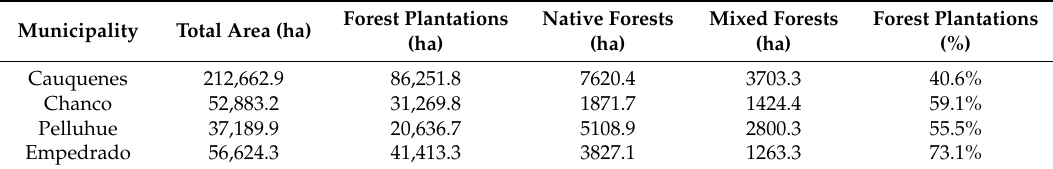
Table 1. Forest plantations, and native and mixed forest in the study area. Calculations based on Chilean native vegetal cadastre of resources, 2014 [25].